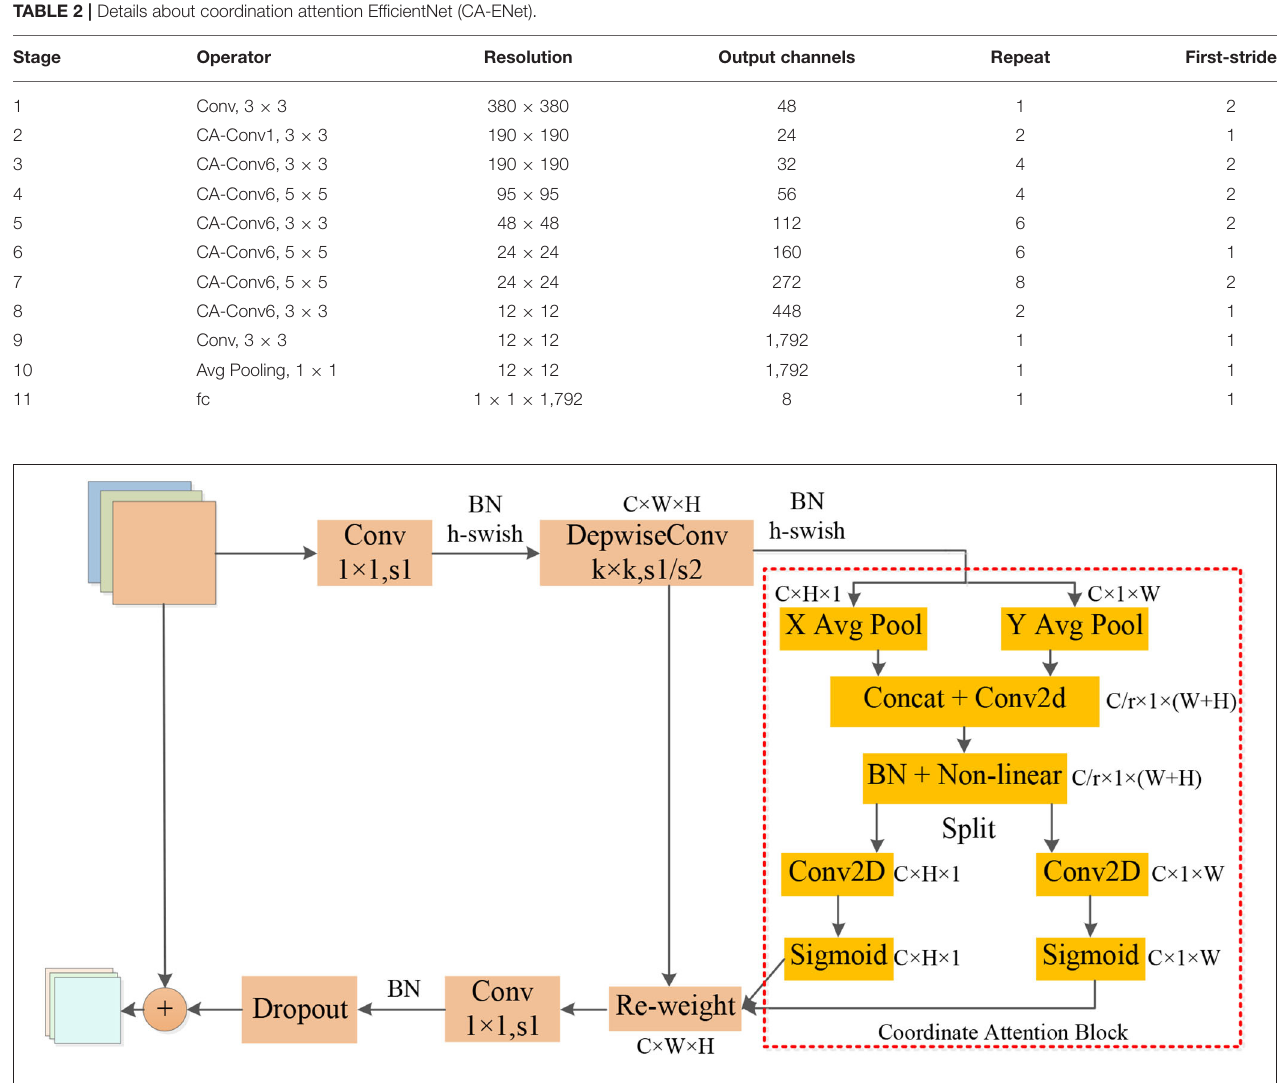
FIGURE 4 | Structure of coordination attention convolutional